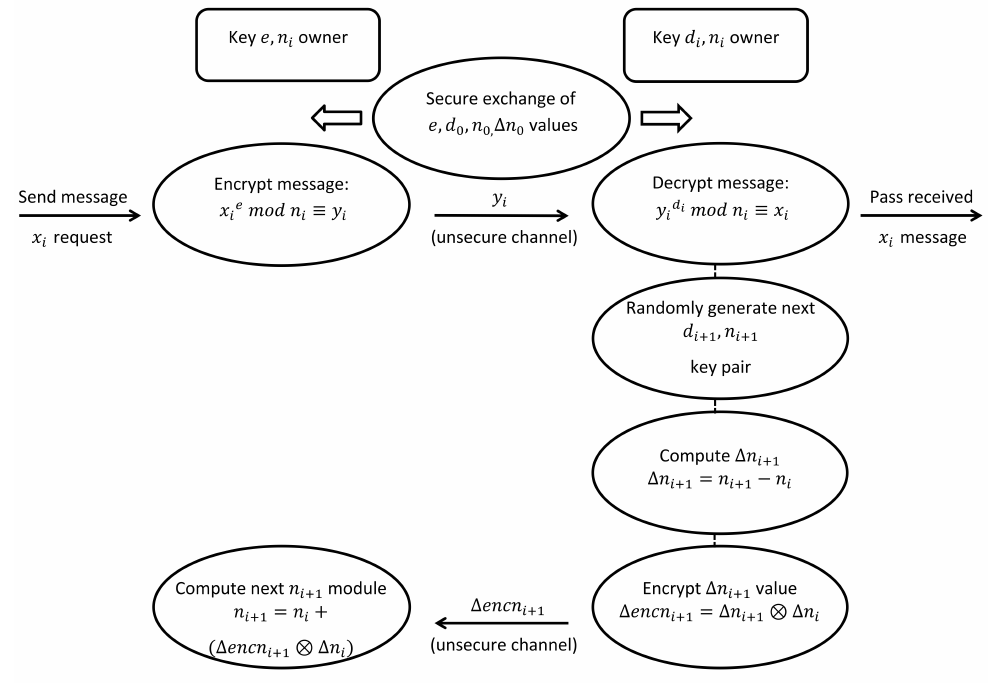
Figure 4. Improved RSA-OTP